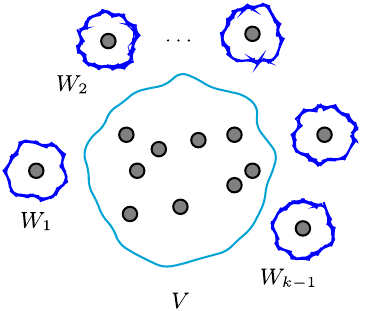
Fig. 3 Local structure of the total system and the choice of subsystems in the 2k-OTOC (cid:2) dW 1 . . . dW k − 1 Haar